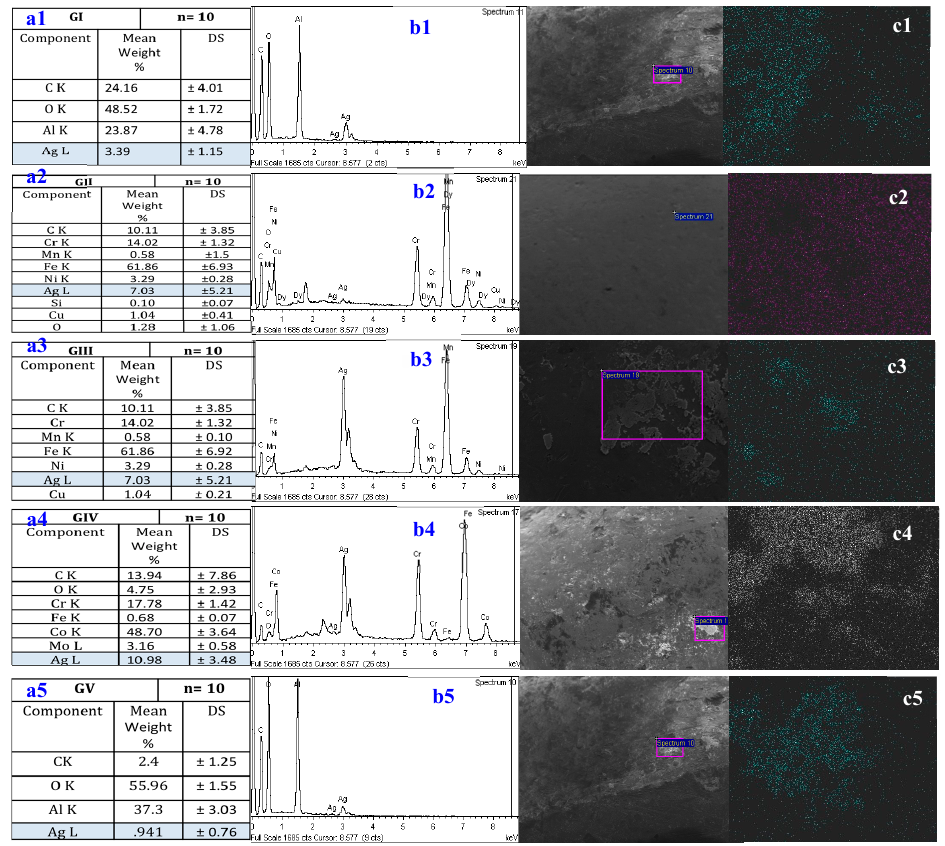
Figure 2. ( a1 – a5 ) Mean and standard deviation by group: GI, GII, GIII, GIV and GV; ( b1 – b5 ) representative spectrum from the chemical composition of the silver nanoparticles obtained by energy-dispersivespectroscopy(EDS);( c1 – c5 )mappinganalysisbasedonSEMofthesilvernanoparticles on the brackets synthesized via the method proposed in